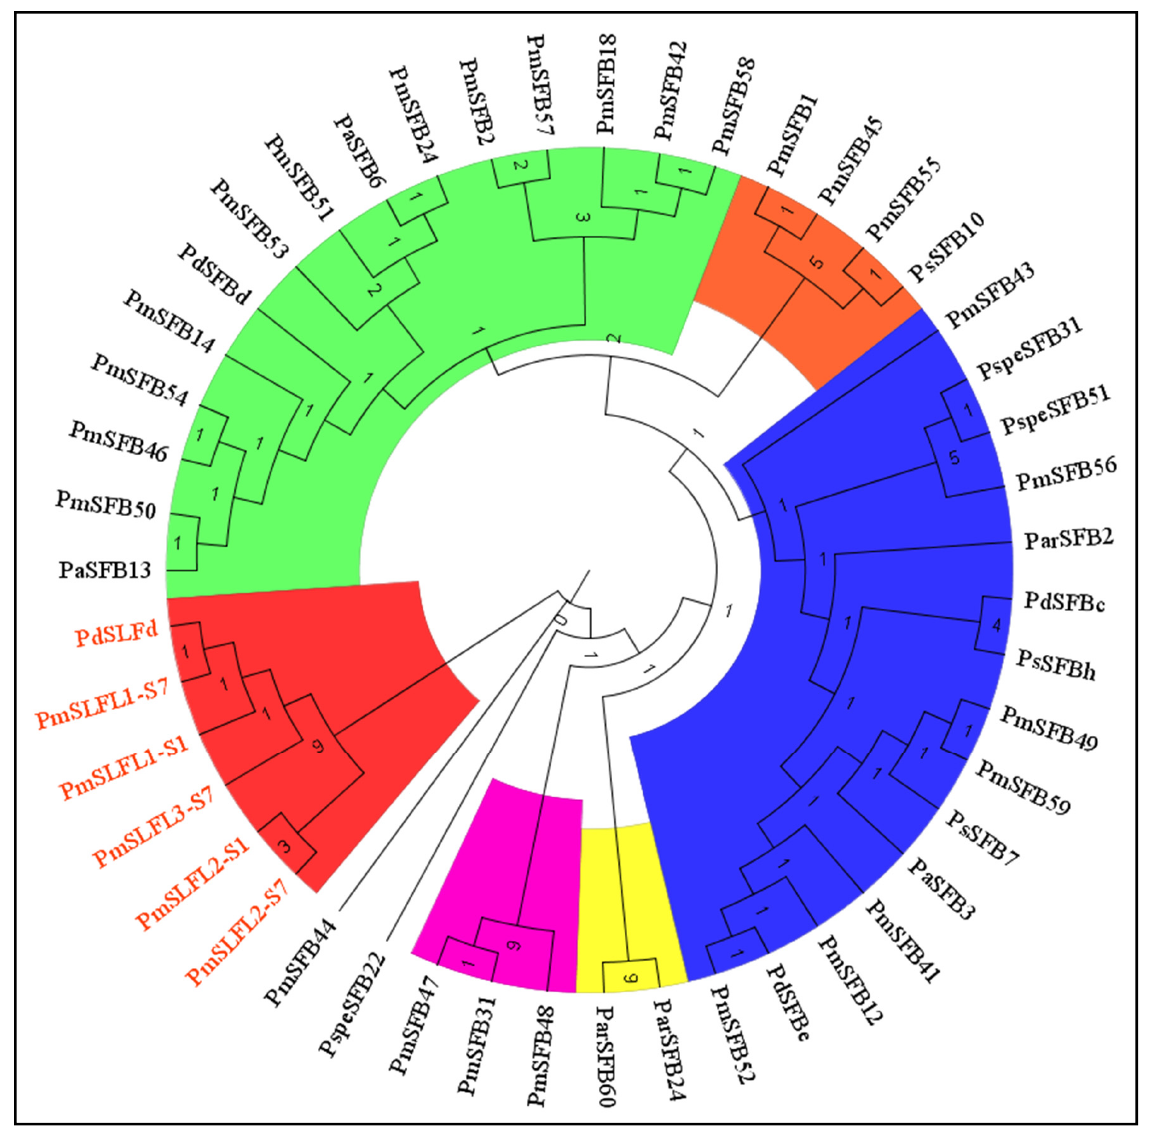
Figure 6. The phylogenetic tree was constructed based on the amino acid sequence using the neigh- bor-joining method of 47 S-locus F-box genes ( SFB and SLFL ) from, P. armeniaca (Par), P. avium (Pa), P. dulcis (Pd), P. salicina (Ps), P. speciosa (Pspe), and P. mume (Pm). GenBank accession numbers : ParSFB1 (AY587563), ParSFB 2 (AY587562), PaSFB 1 (AY805048), PdSFB a (AB092966), PdSFBd (AB081648), PdSFBc (AB079776), PmSLFL1-S1 (AB092623), PmSLFL1-S7 (AB092624), PmSLFL2-S1 (AB092625), PmSLFL2-S7 (AB092626), PmSLFL3-S7 (AB092627), PdSLFd (AB101660), PaSLF1-S1 (AB360339), PaSLF1-S2 (AB360340), PsSFBb (AB252412), PsSFBc (AB280792), PspeSFB 1 (HM347508), and PspeSFB 22 (HM347509); PmSFB 1 (AB101440), PmSFB 12 (JQ356586), PmSFB 42 (JQ356581), PmSFB 43 (JQ356578), PmSFB 41 (JQ356593), PmSFB 40 (JQ356585), and PmSFB accession numbers are detailed in the text.